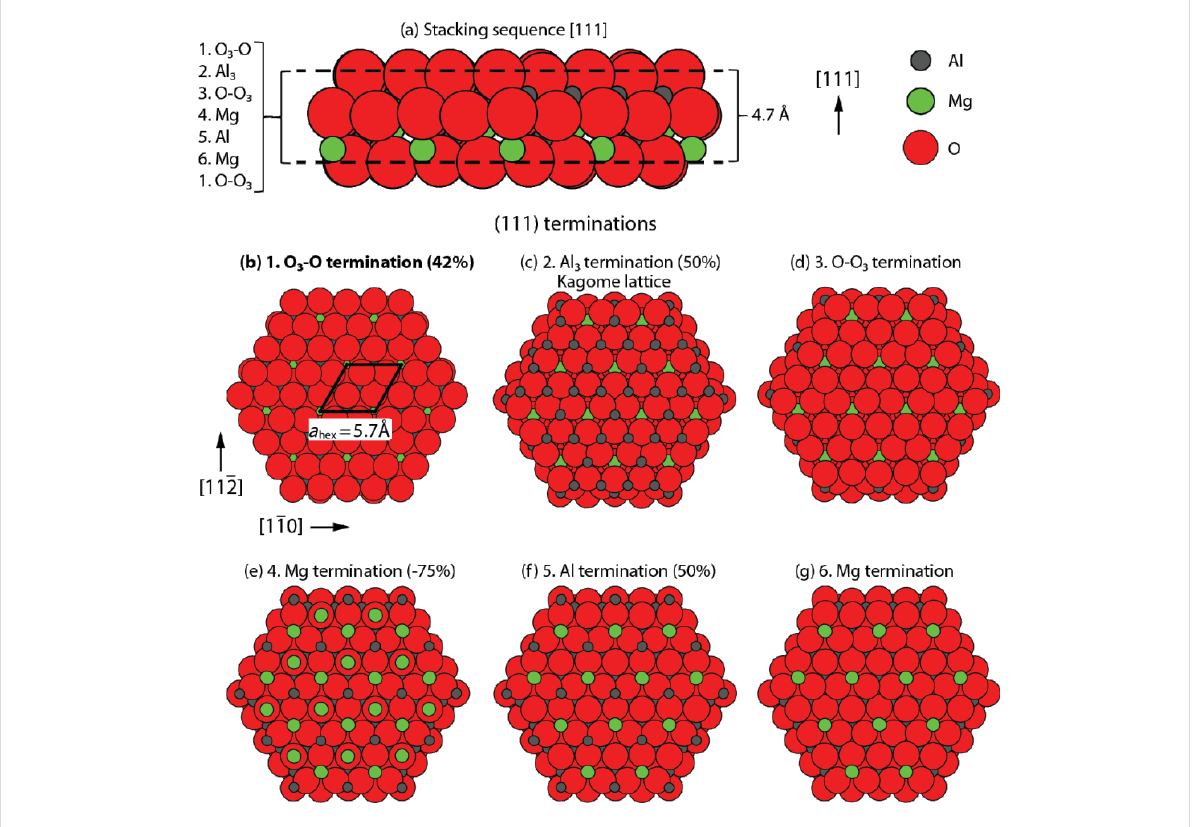
Figure 1: (a) Ball model of the MgAl 2 O 4 stacking sequence in the [111] direction showing one repeat unit of 4.67 Å in height. (b–g) The hexagonal patches show six ball models, which illustrate the possible surfaces obtained from a bulk-truncation of the sequence in